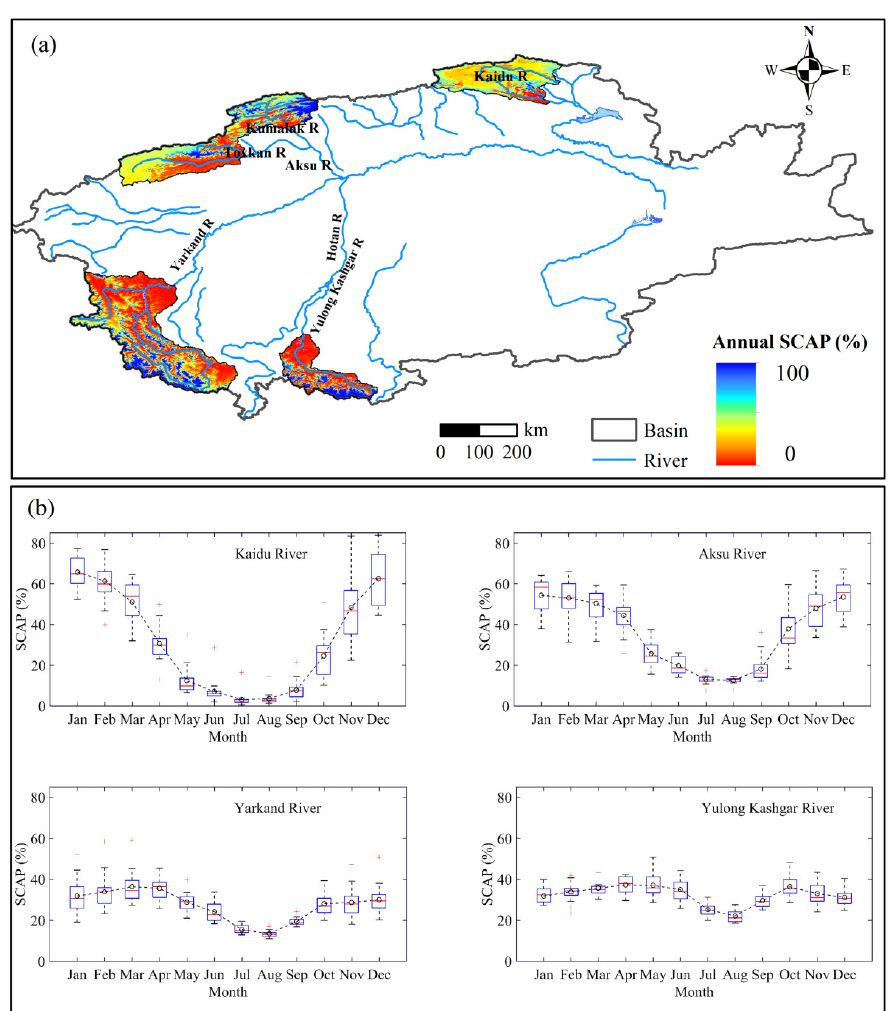
Figure 4. Average annual and monthly SCAP in the Kaidu River Basin, the Aksu River Basin, the Yarkand River Basin, and the Yulong Kashgar River Basin over the period of 2001–2019. ( a ) Spatial averaged SCAP in the Tarim River Basin; ( b ) monthly SCAP in different sub-basins of the Tarim River Basin. Table 3. Characteristics of annual and seasonal SCAP in four typical river basins in the TRB.